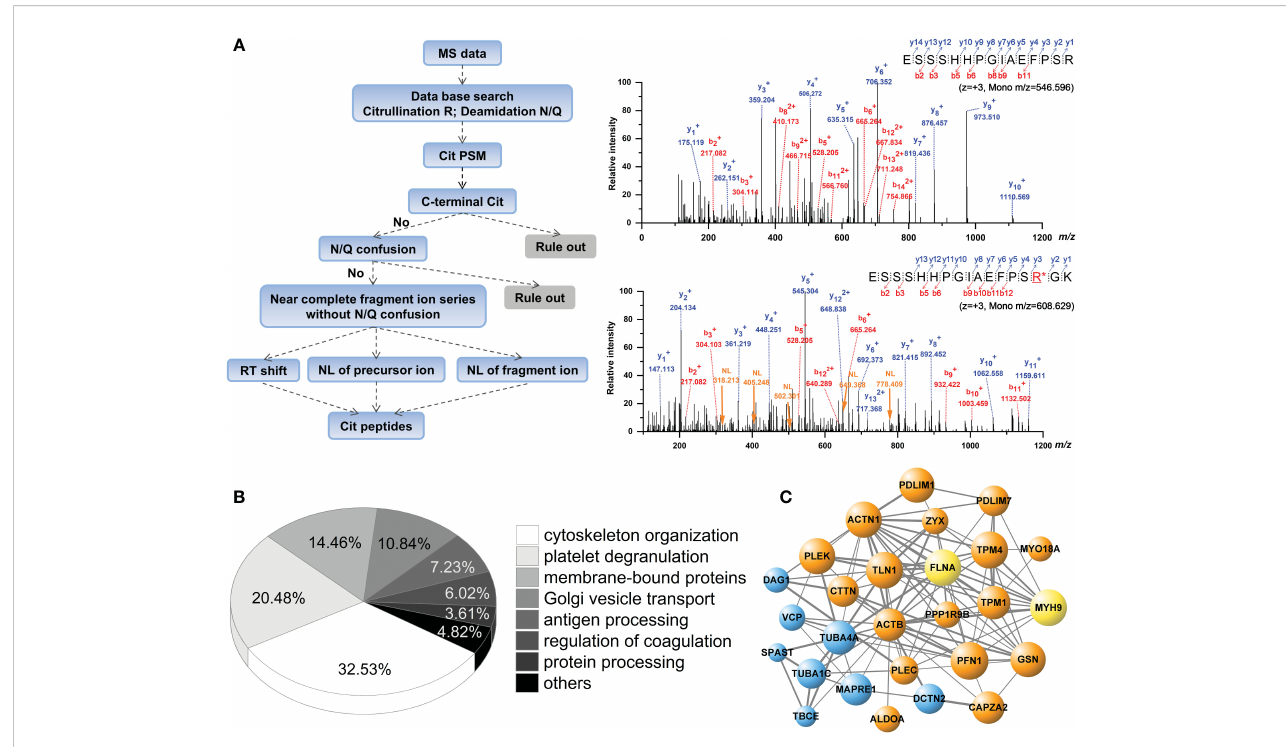
FIGURE 2 Analysis of citrullinated peptides present in the human platelets by mass spectrometry. (A) Decision tree for the identi fi cation of citrullination is shown in the left panel. Representative dimer-isotopic MS2 spectrum of non-citrullinated and citrullinated 560E – 575K peptide of human fi brinogen a is shown in the right panel. Purple arrow indicates the neutral loss fragment (NL, -43.0058 Da) corresponding to y3+~y7+ ions. (B) Pie-chart showing the classi fi cation of identi fi ed citrullinated proteins in the platelets, according to functional categories. (C) Protein interaction network of citrullinated proteins. Orange bobbles show the actin-myosin fi laments; blue bobbles show the microtubules; yellow bobbles show the actin-myosin fi laments and microtubules.